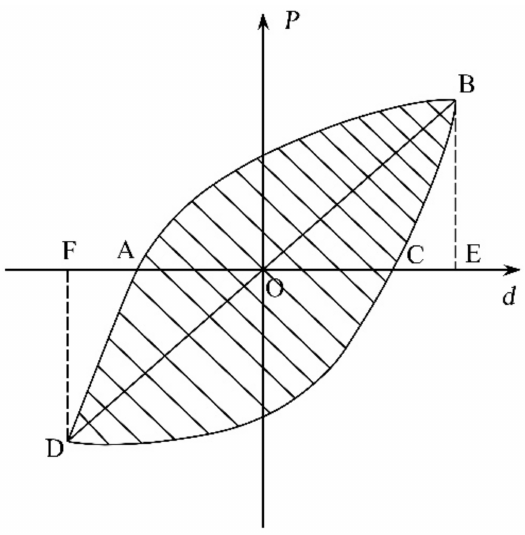
Figure 14. P- ∆ hysteresis loop of the